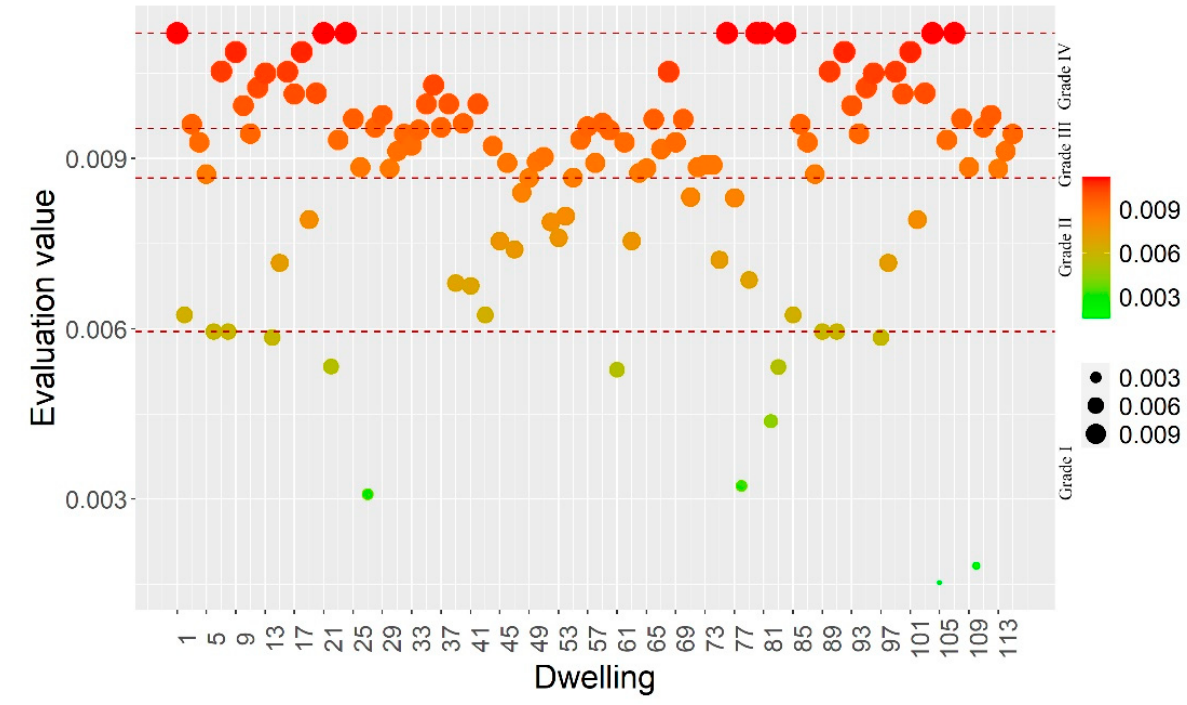
Figure 8. Scatter plot of the evaluation values of different residences.